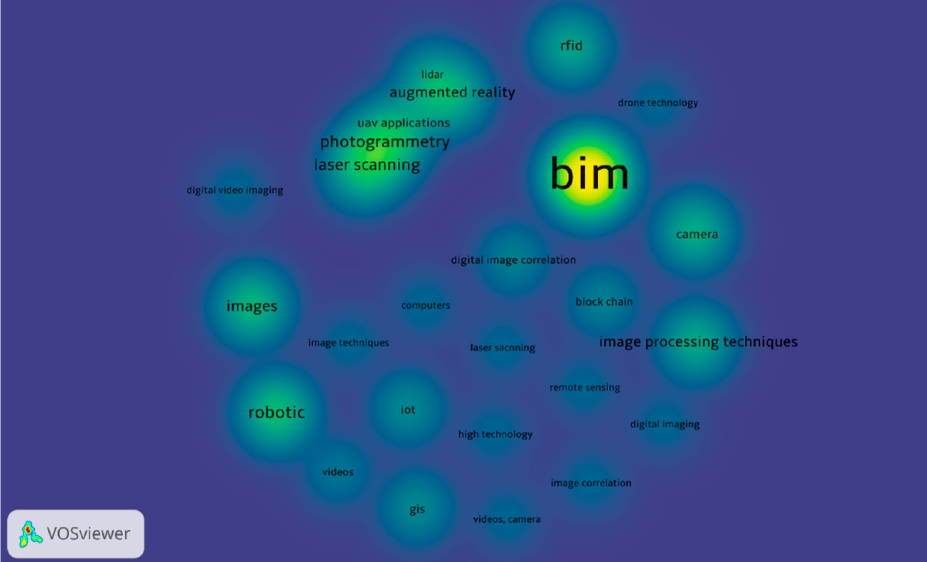
Figure 6. Mapping of DTs in the AEC industry.